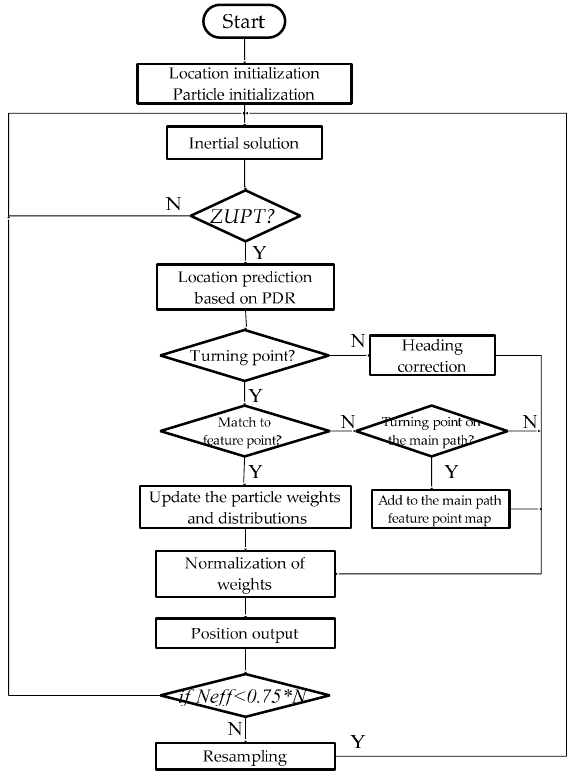
Figure 8. Flow chart of the particle filter-simultaneous localization and map building (PF-SLAM) location algorithm based on the feature point map.